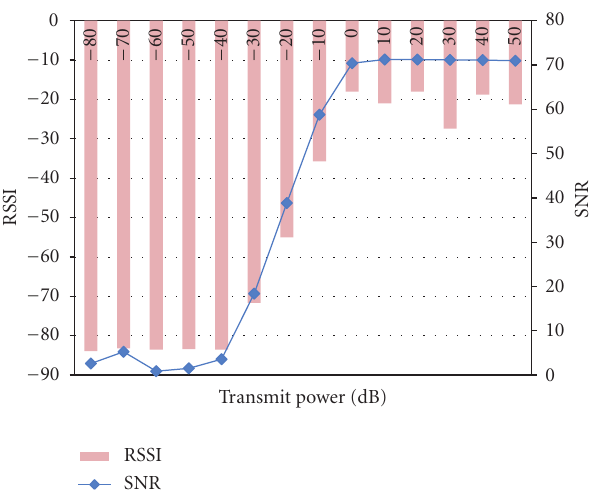
Figure 5: RSSI and SNR as the software gain is varied. RSSI is on the left axis and SNR is on the right axis. This illustrates the usable range of the transmit power parameter as between − 40 dB and 0dB.